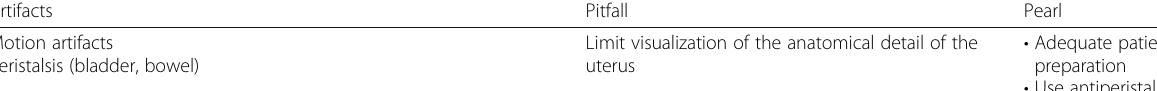
Limit visualization of the anatomical detail of the uterus